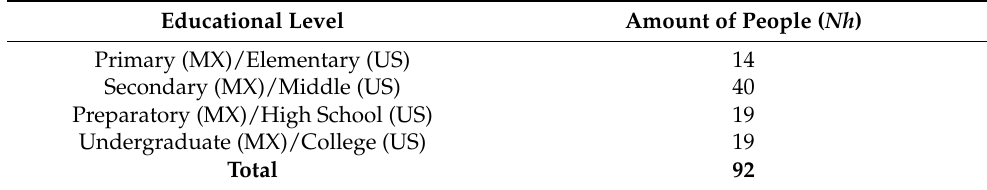
Table 1. Subpopulation samples for educational levels based on the Mexican education